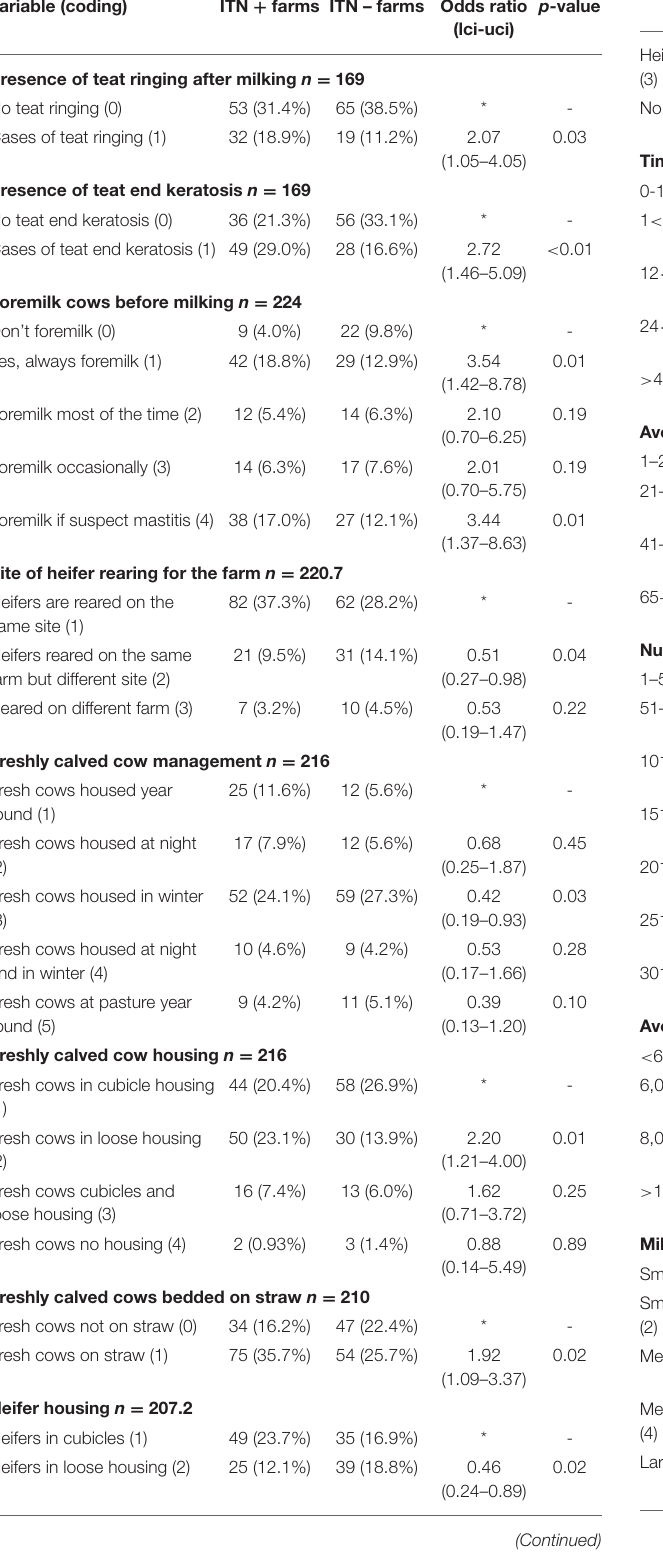
TABLE 2C | Univariable management and milking machine factors associations with ischemic teat necrosis (ITN) as the outcome variable. Variable